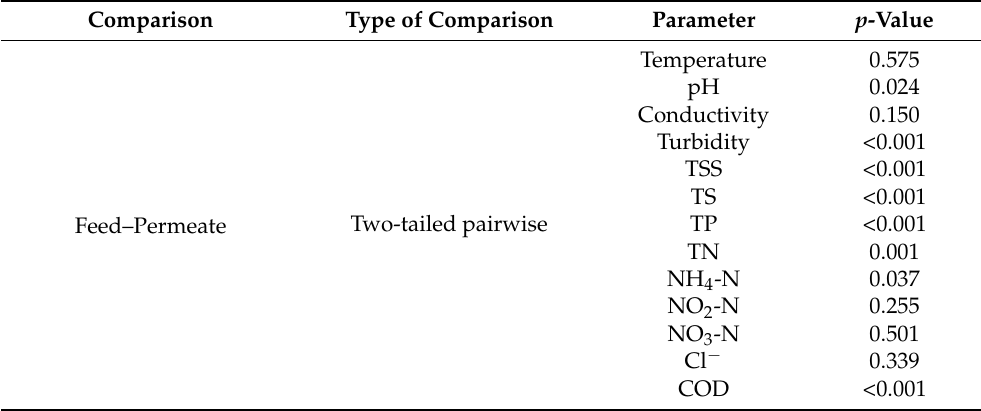
Table A2. Statistical analysis ( t -test) of the effect of membrane filtration on the physicochemical characteristics of membrane